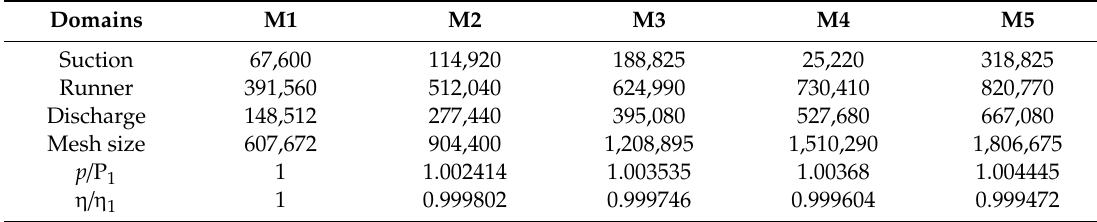
Table 2. Grid size in relation to turbine power (P) and efficiency (η).